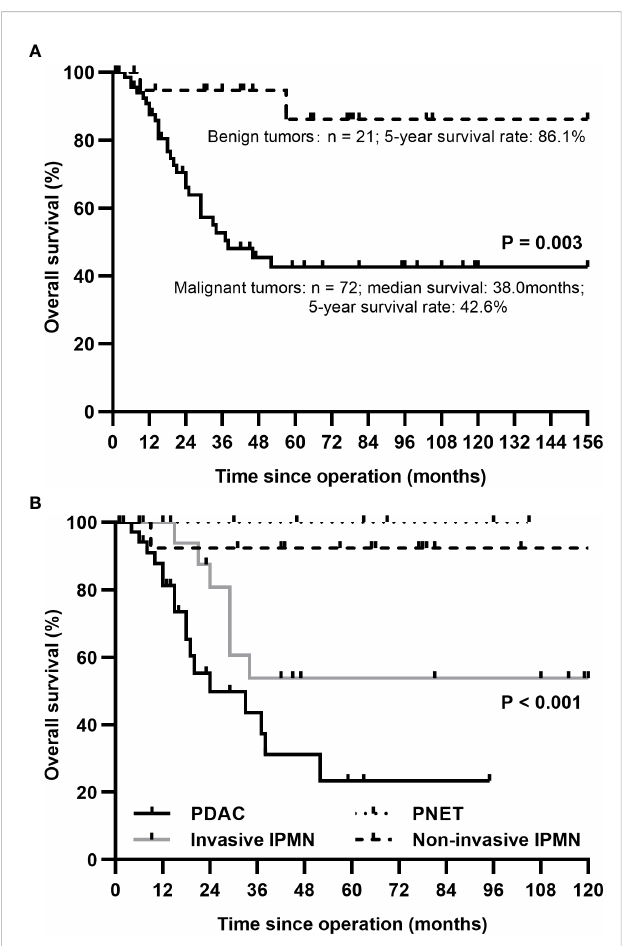
FIGURE 3 The Kaplan-Meier survival curve for patients after total pancreatectomy according to underlying diseases. (A) A better survival rate was identi fi ed in benign tumors compared with malignant tumors. (B) 1-year survival rates for patients with PDAC, invasive IPMN, non- invasive IPMN, and PNET: 81.2%, 100%, 92.3%, 100%; 3-year: 43.5%, 53.8%, 92.3%, 100%; 5-year: 23.3%, 53.8%, 92.3%, 100%. PDAC, pancreatic ductal adenocarcinoma; IPMN, intraductal